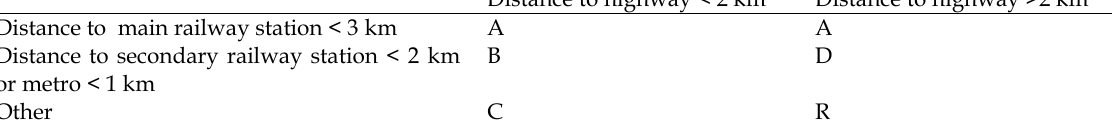
Table 3. Typology of